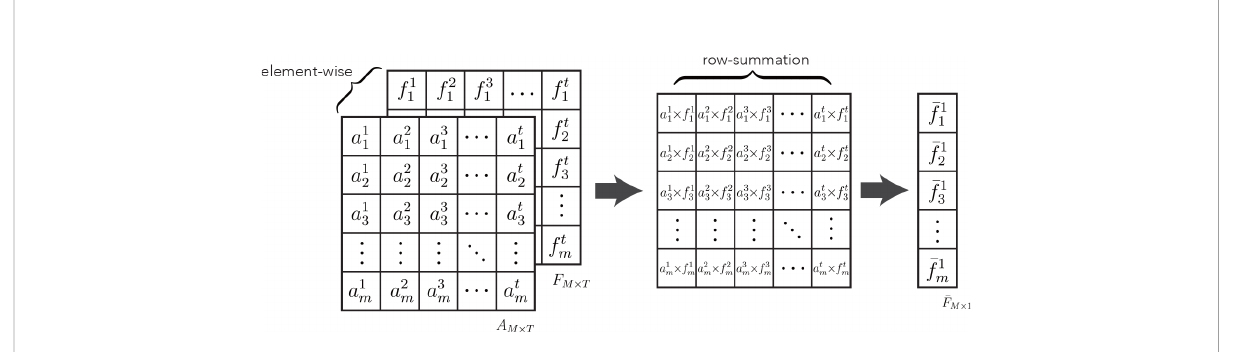
FIGURE 4 Schematic illustration of multi-meta attention operation .